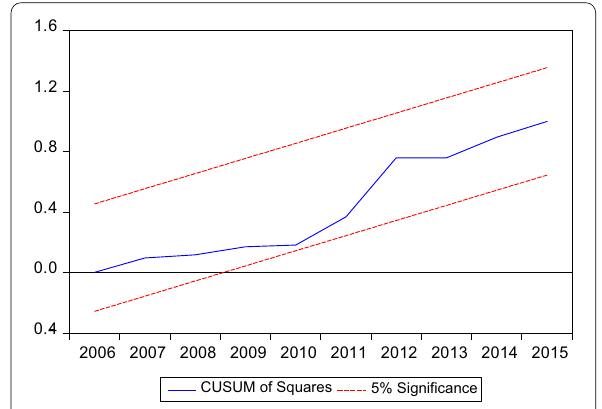
Fig. 6 Cumulative sum of square recursive residuals